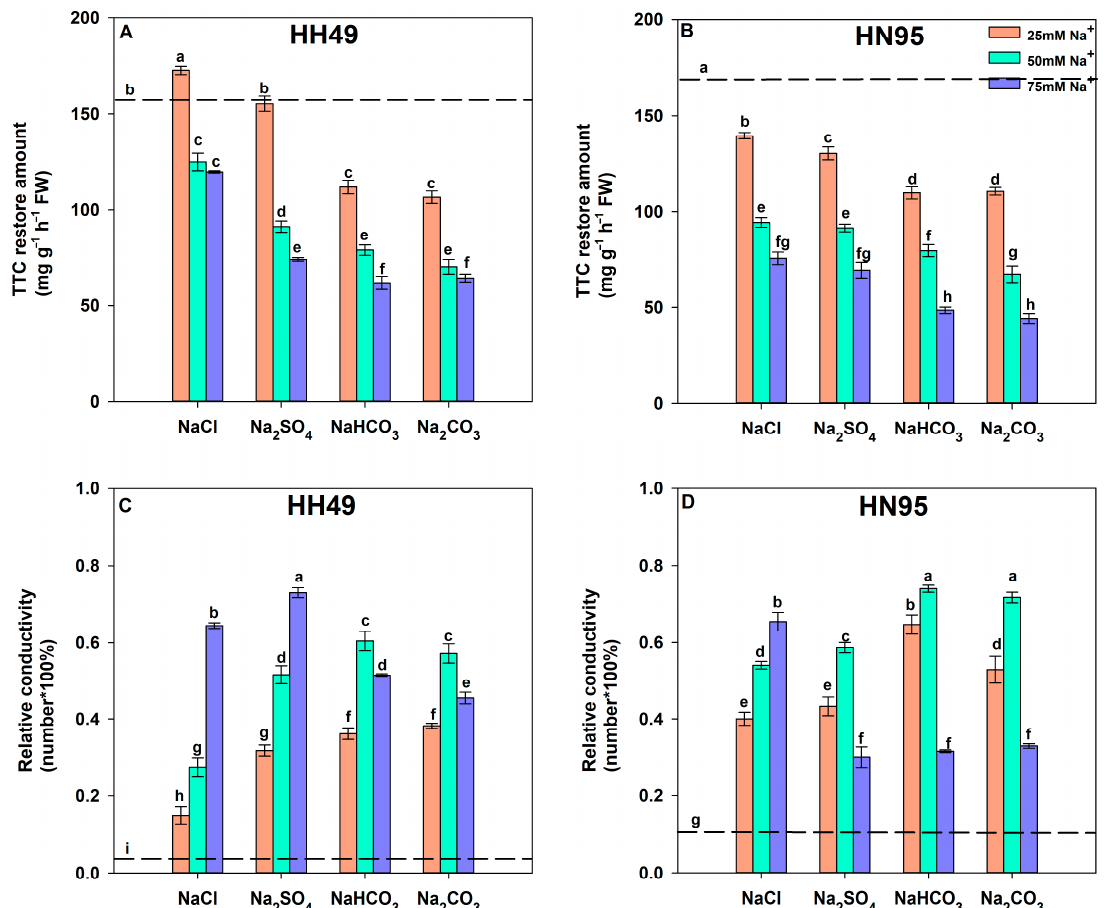
Figure 2. Root activity and relative conductivity of soybean seedling roots treated with different salt stress for 3 days. The TTC restoration amount of HH49 ( A ) and HN95 ( B ) seedling roots treated with different Na + concentration solutions in the formulas of NaCl, Na 2 SO 4 , NaHCO 3 , and Na 2 CO 3 . The relative conductivity of HH49 ( C ) and HN95 ( D ) seedling roots treated with different Na + concentration solutions in the formulas of NaCl, Na 2 SO 4 , NaHCO 3 , and Na 2 CO 3 . Dashed lines in ( A – D ) indicate TTC restoration amount and relative conductivity of HH49 and HN95 seedling roots under the control conditions. Data are expressed as means ± SD of three independent experiments. Different letters indicate statistically significant differences ( p < 0.05) among treatments.